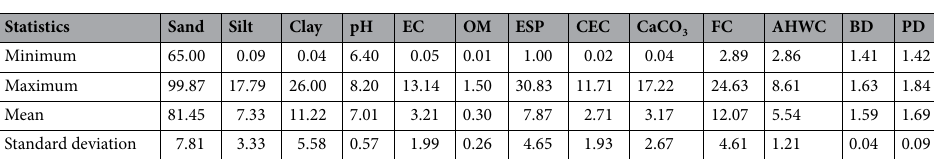
Table 13. Statistics summarize of the used